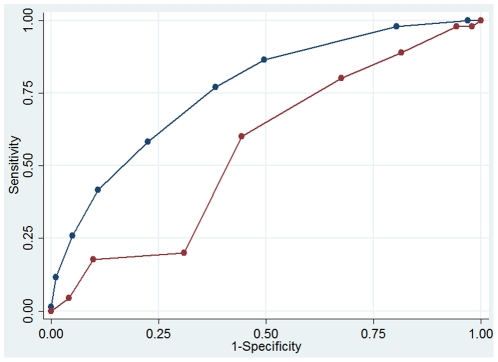
Comparison of ROC curves for the score in patients without (blue) and
with (red) previous history tuberculosis.